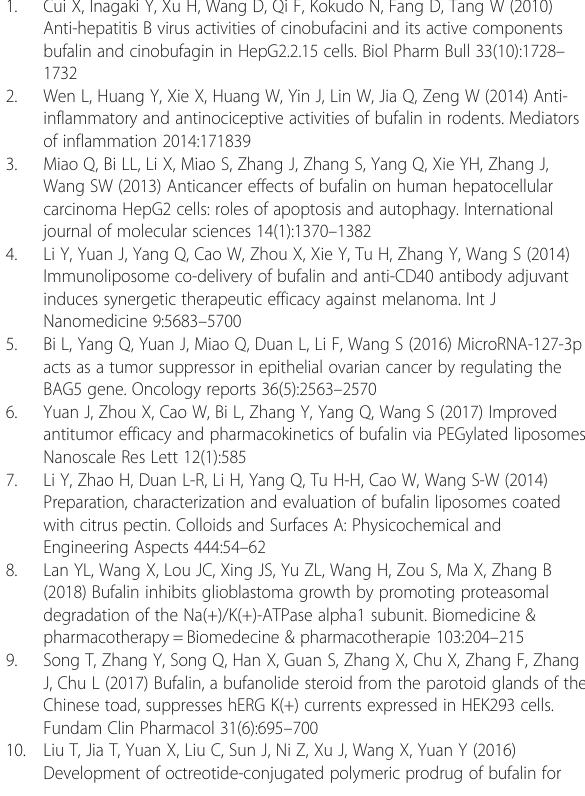
Additional file 1: Figure S1. Characterization of PEGylated liposomes containing bufalin. Figure S2. Representative chromatograms of BF and CBG (IS) in rat tissue homogenate samples. Table S1. The precision, accuracy and recovery experiments of bufalin in biological samples ( n = 5). Table S2. The stability experiments of bufalin in biological samples ( n = 5). Table S3. The tissue distribution of BF in rat organs. (DOCX 822 kb)